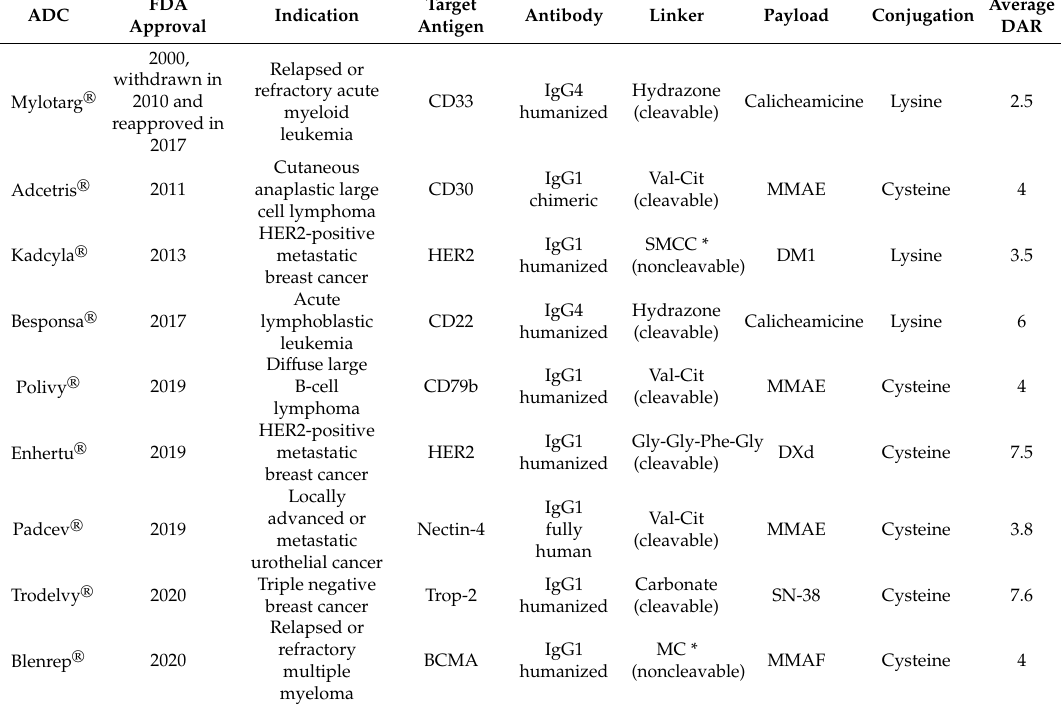
Table 1. Antibody–drug conjugates (ADCs) approved by the Food and Drug Administration (FDA).